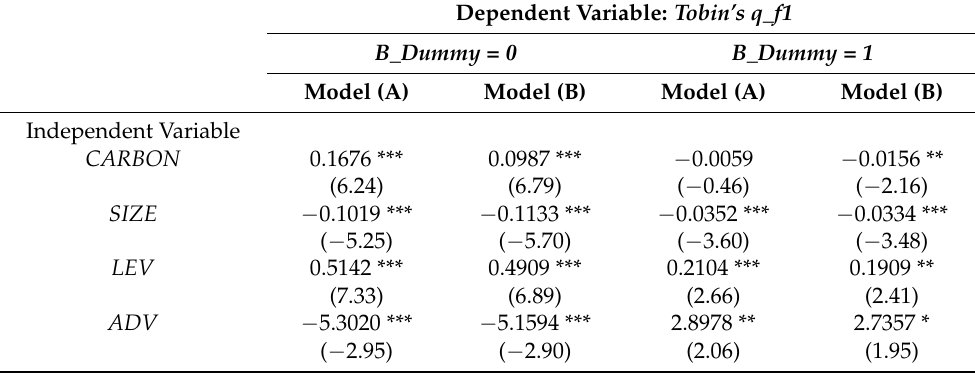
Table 5. Relation Between Carbon Emissions and Financial Performance Based on Board Indepen-